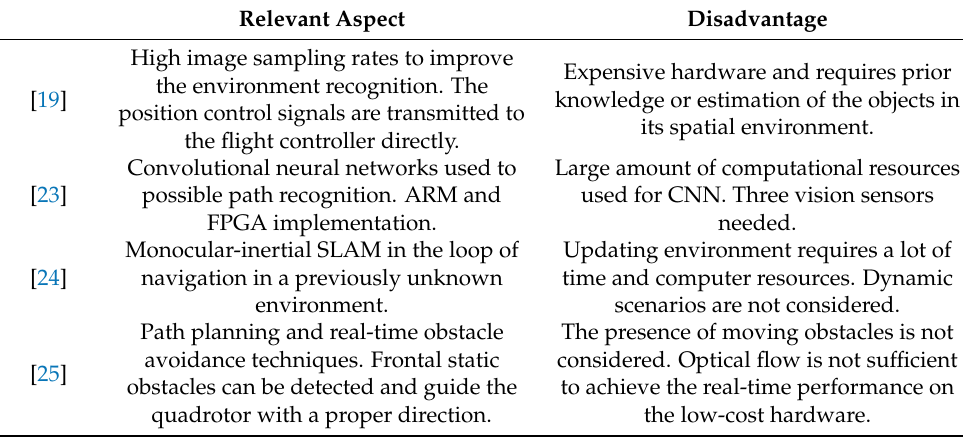
Table 1. Comparation between different UAV trajectories’ generation